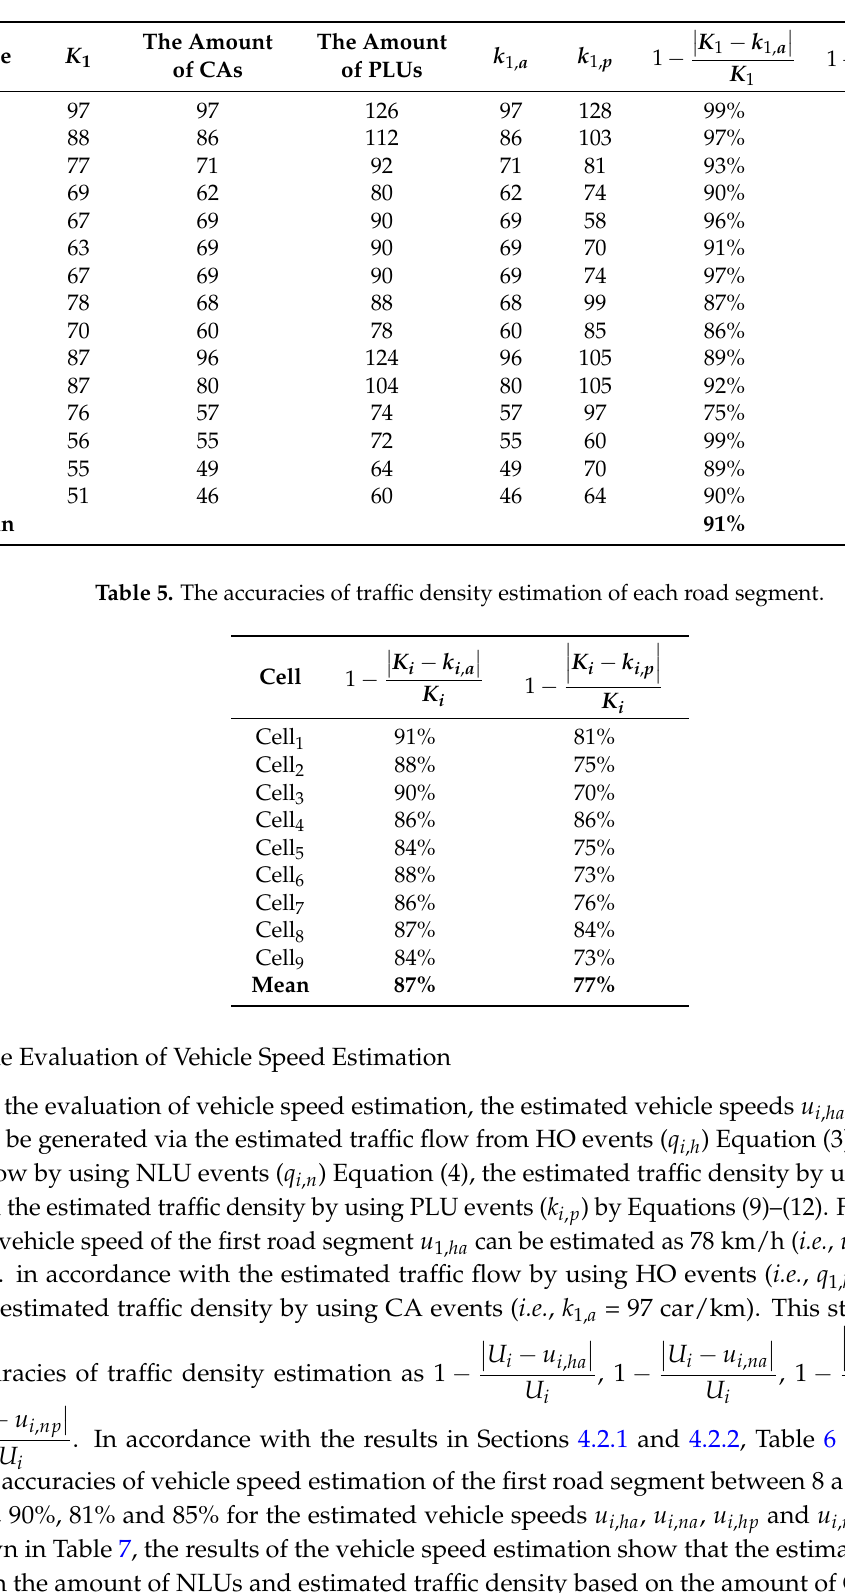
Table 4. The accuracies of traffic density estimation of the road segment covered by Cell 1 .